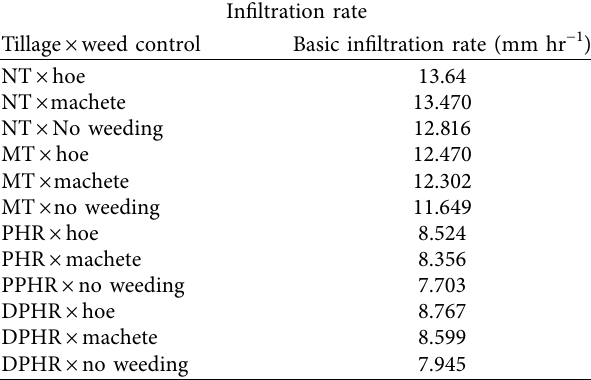
Table 9: Tillage and weed control methods’ interaction effect on infiltration rate.